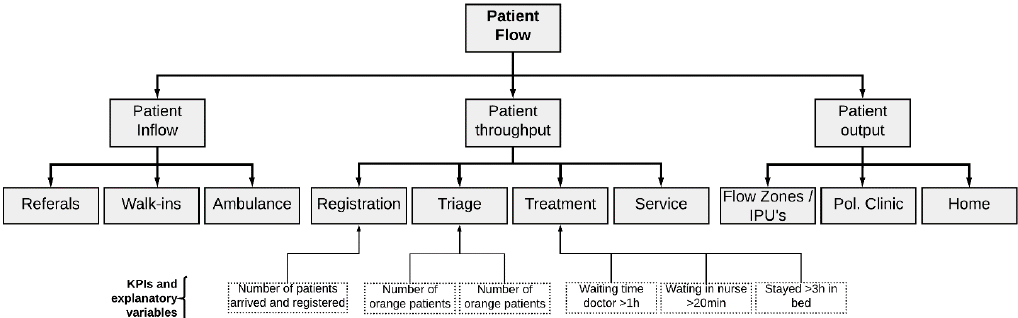
Figure 10. Purpose tree breakdown structure and KPIs for ED operations.